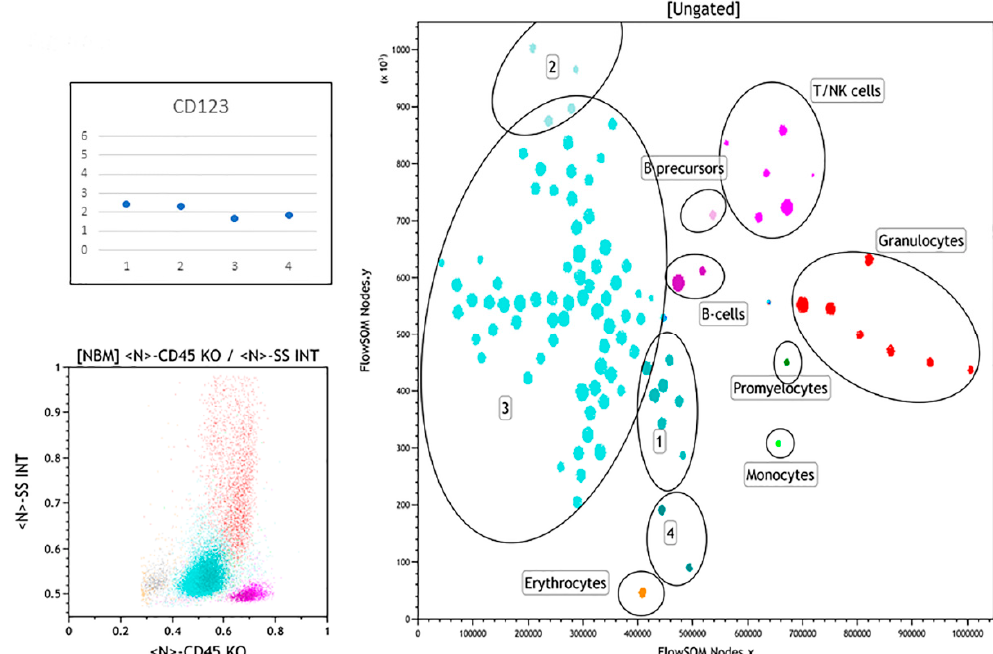
Figure 5. FlowSOM analysis of Case 4. Minimal spanning tree is shown in the right panel. FlowSOM segregates the apparently clustered population of progenitors (left CD45/SSC scattergram) in an impressively large number of nodes that may be re-clustered in 4 populations (Supplementary Table S7). Two subsets of CD34 + /CD117 + /CD123 + blasts were found: one CD33/CD38 negative and one with CD38 and CD33 expression. Normalised MFI of CD123 expression in numbered progenitor subsets is illustrated in the upper left diagram and back-gating on the CD45/SSC plot is given in the lower-left panel. There is no clear mature PDC population in this case.